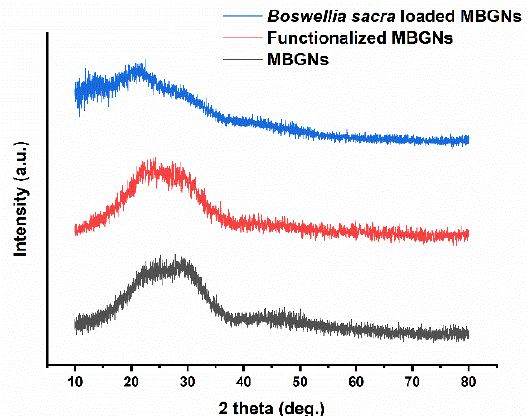
Figure 4. XRD patterns of MBGNs, functionalized MBGNs and after loading of Boswellia sacra ex- tract.